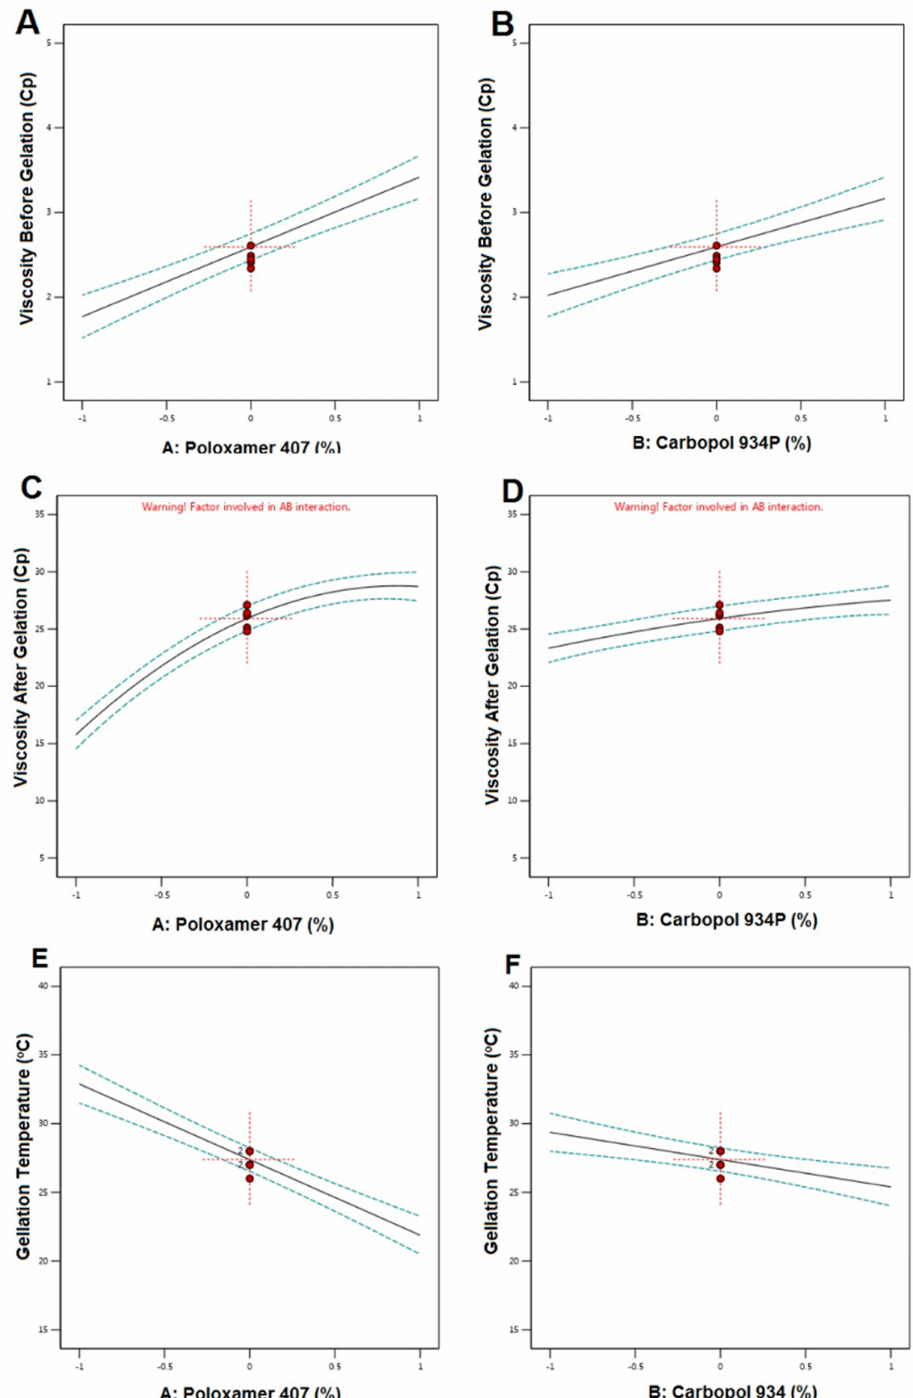
Figure 5. Main e ff ect diagram representing the e ff ect of studied variables on viscosity before gelation (Y1), viscosity after gelation (Y2), and gelation temperature (Y3). ( A ). Main e ff ect plot showing the e ff ect of Poloxamer 407 % on the viscosity before gelation; ( B ). Main e ff ect plot showing the e ff ect of Carbopol 934% on the viscosity before gelation; ( C ). Main e ff ect plot showing the e ff ect of Poloxamer 407 % on the viscosity after gelation; ( D ). Main e ff ect plot showing the e ff ect of Carbopol 934% on the viscosity after gelation; ( E ). Main e ff ect plot showing the e ff ect of Poloxamer 407 % on the gelation temperature. ( F ). Main e ff ect plot showing the e ff ect of Carbopol 934% on the gelation